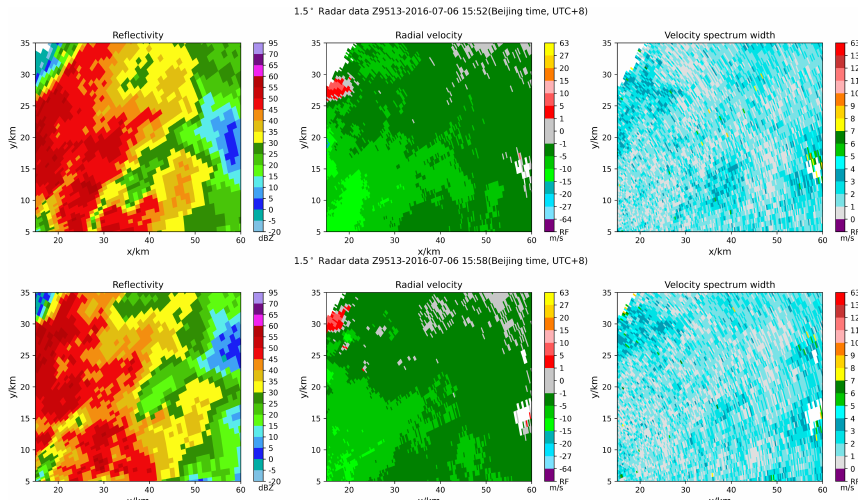
Figure A3. 1.5 ◦ radar data for the second tornado case, Z9513-2016-0706 15:52 and 15:58 (UTC+8), the tornado was EF0. The radial velocity has not any tornado vortex signaures, and TDA-TVS algorithm fails to warn the tornado.